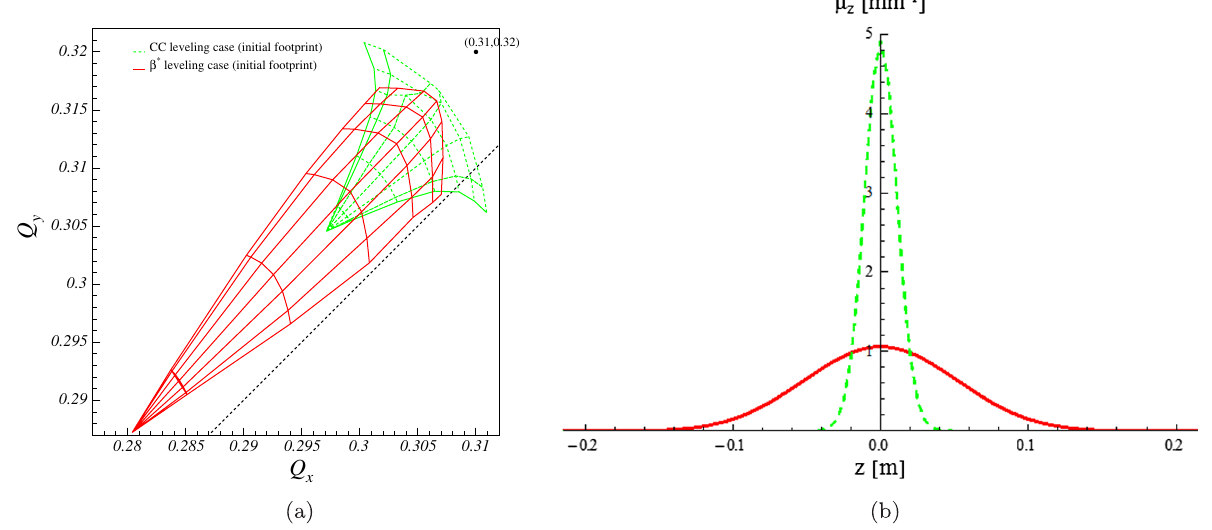
FIG. 6. Leveling the HL-LHC luminosity by acting either on the crabbing angle (dashed line) at constant (minimum) β (cid:1) , or on β (cid:1) itself (solid lines) at constant (full) crabbing angle: main pros and cons in terms of line pile up density (b) and beam-beam effects [as illustrated in (a) for the corresponding tune footprints up to 6 σ betatron amplitude]. The line PU density is in particular well beyond the limits for the first option, of the order of ˆ μ z ≈ 5 events = mm at the beginning of the store, although the situation would be very favorable in terms of beam-beam tune shift. The beam-beam tune shift is on the contrary maximized for the second option, reaching up to Δ Q bb ≈ 0 . 03 at full current and assuming three insertions providing head-on or nearly head-on collisions (i.e., including the contribution of LHCb not equipped with crab-cavities but running at rather large β (cid:1) and therefore rather small Piwinsky